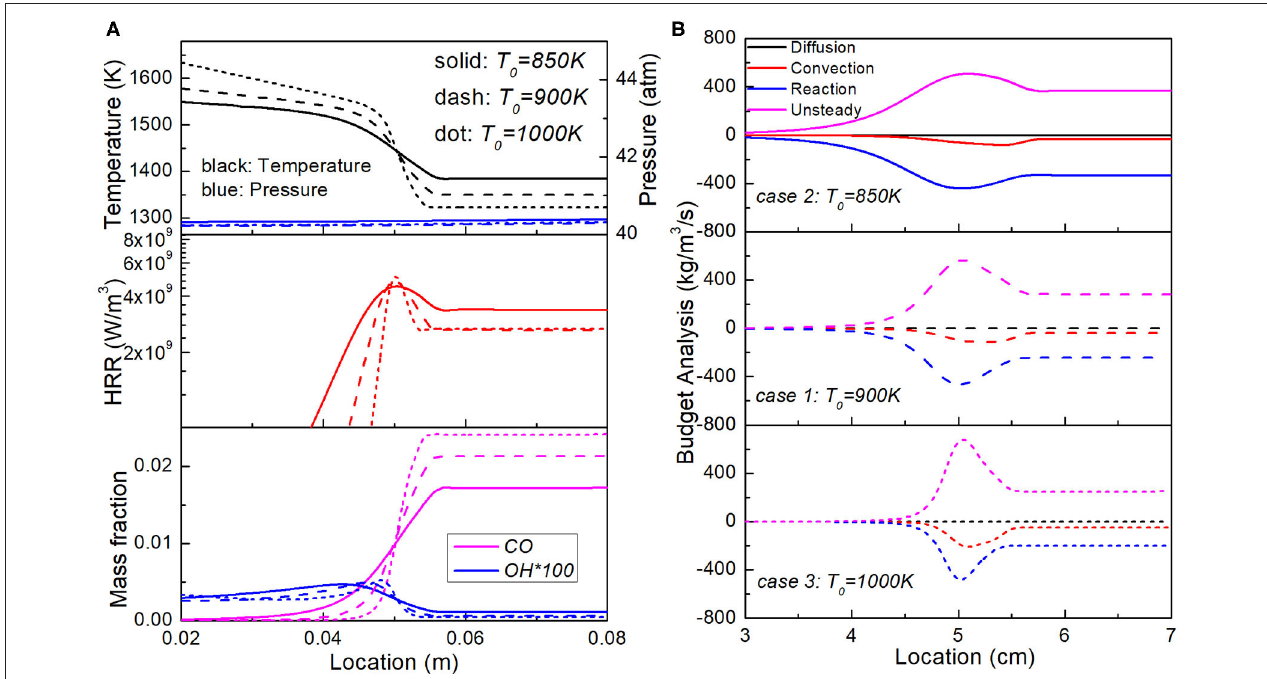
FIGURE 7 | Comparison of the (A) Temperature, pressure, heat release rate and key species fraction profiles and (B) budget analysis of CO mass fraction in Case 1, 2, and 3 with the same lengths of temperature stratification segment but different temperature range.